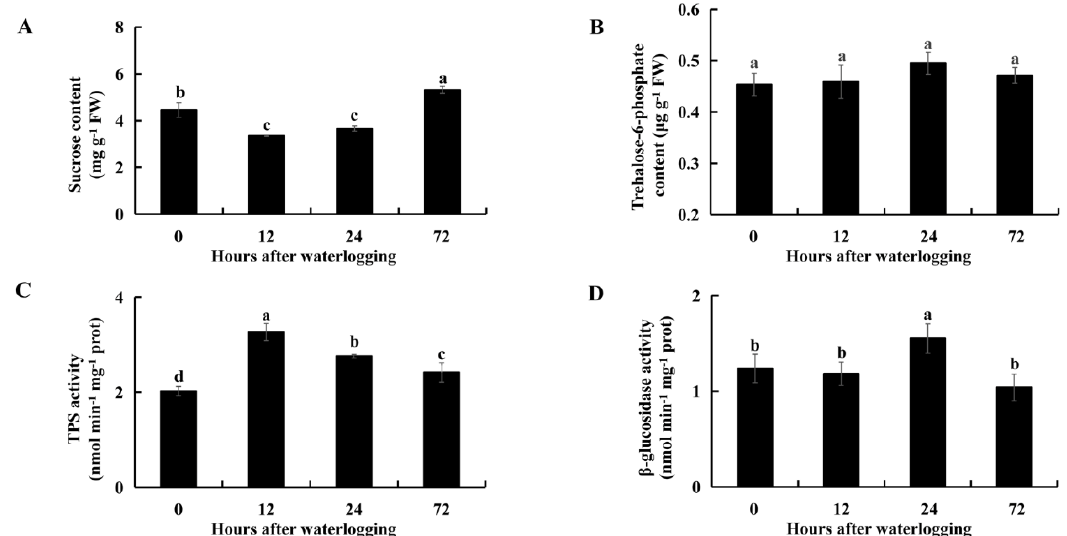
Figure 5. Changes in sucrose (A) and T6P (B) contents, as well as TPS (C) and β -glucosidase (D) activity in KR5 roots under waterlogging stress. Data are expressed as averages ± SD, n = 3. Significant differences between treatments at p < 0.05 are indicated by different letters over columns (Duncan’s test).